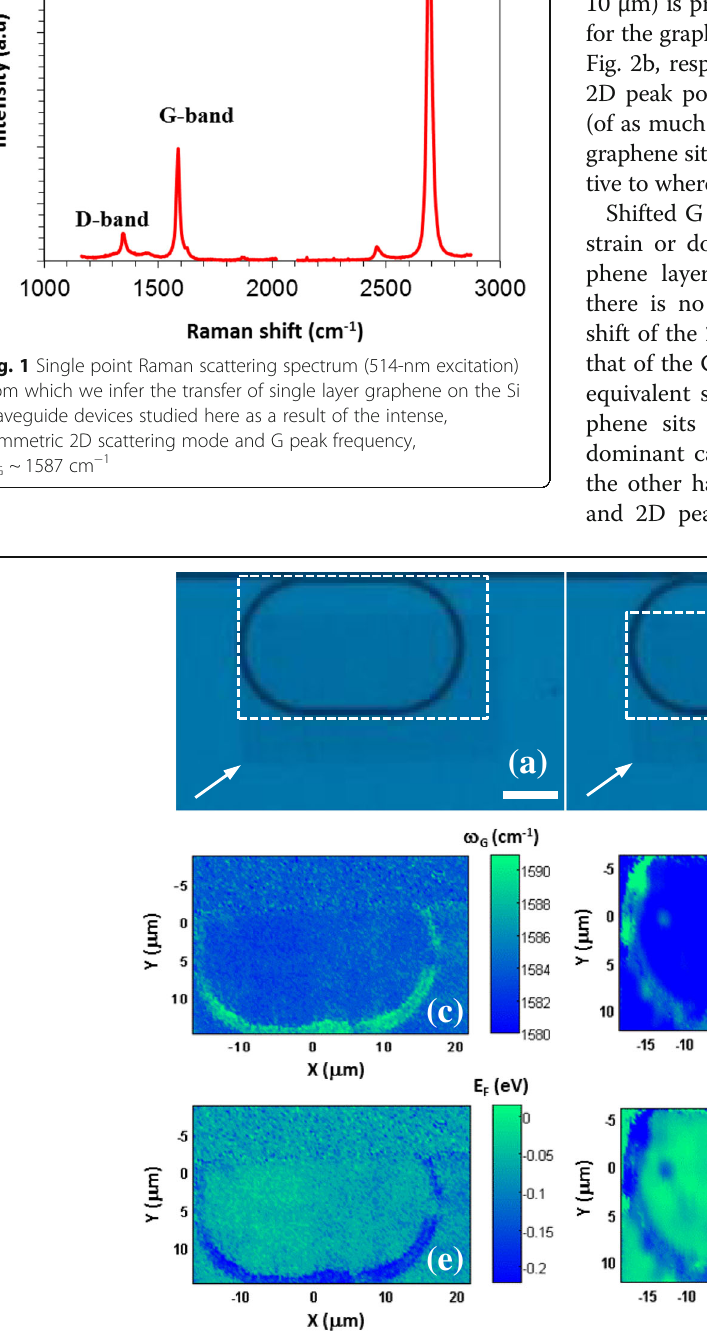
Fig. 2 False colour optical image of the same graphene-coated Si MRR ( r = 10- μ m device) (scale bar = 10 μ m) showing the different mapped re- gions (white dashed squares) for the a G and b 2D peaks, respectively. The graphene is revealed by the slightly darker contrast (with its bottom left hand corner indicated by the arrows). c and d show the corresponding peak positon and e and f the Fermi level maps, determined from Eqs. (1) and (2),